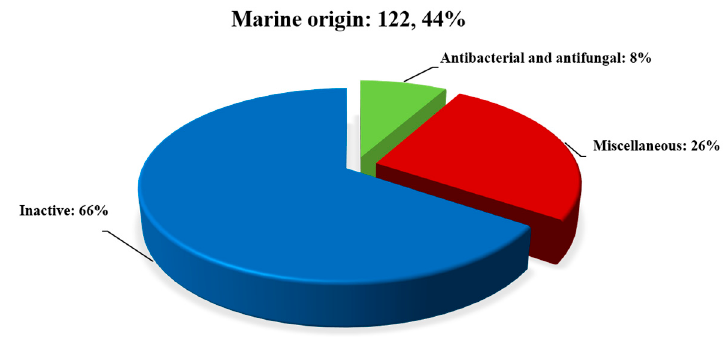
Figure 10. The proportion of secondary metabolites of terrestrial origin.